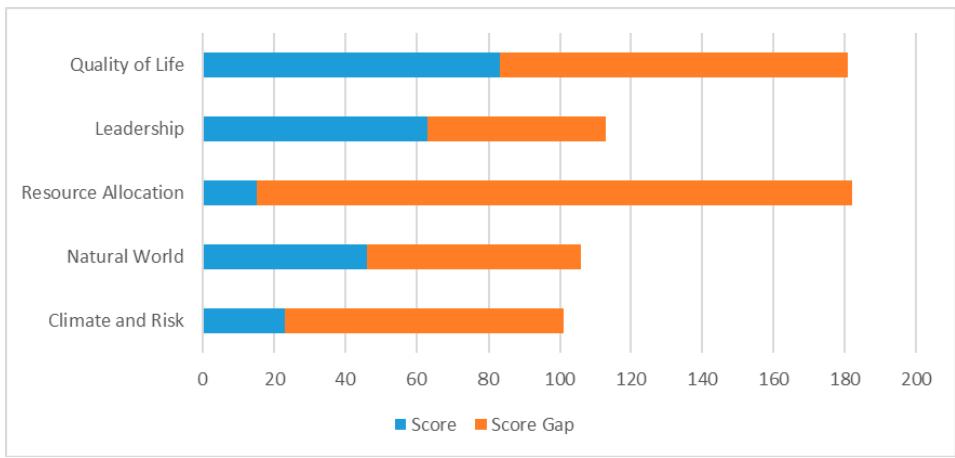
Figure 2. Points achieved in relation to applicable points across each category of the Envision rating system for Project 1.